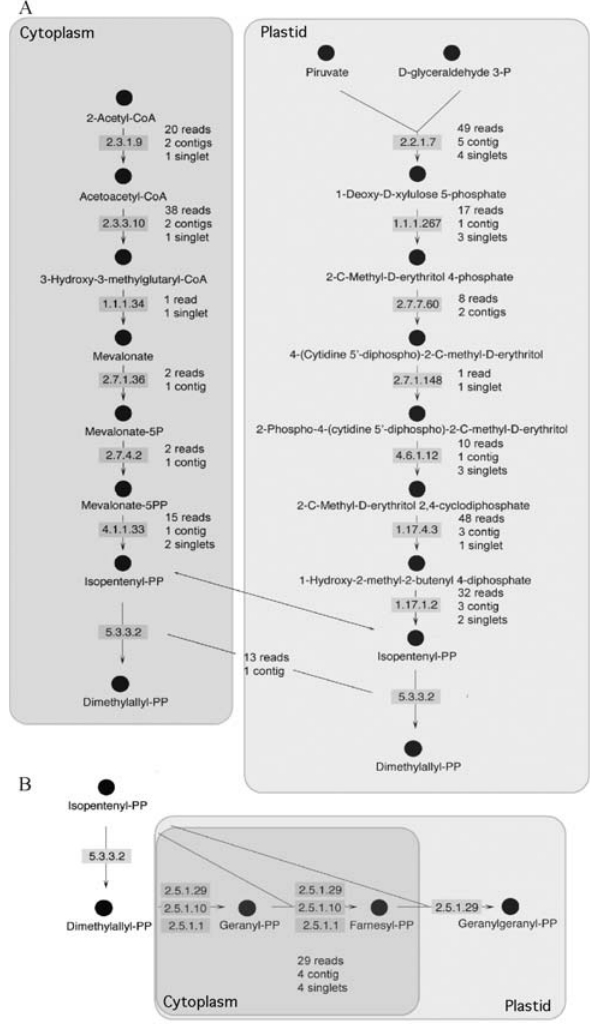
Figure 1 - Pathways for the synthesis of terpenes. Scheme of the reactions that lead to the synthesis of terpenes in plants. The marked enzymes were found in the CitEST database and the number of reads for each enzyme is shown close to the EC number, as well as the number of contigs and singlets obtained after the assembly. A. The two distinct pathways repre- sented in the specific compartments as they occur. B. IPP and DMAPP are converted in geranyl diphosphate, farnesyl diphosphate and geranylgeranyl diphosphate. The first two compounds are formed in both compartments, the cytoplasm and the plastid, while geranylgeranyl diphosphate is produced in the